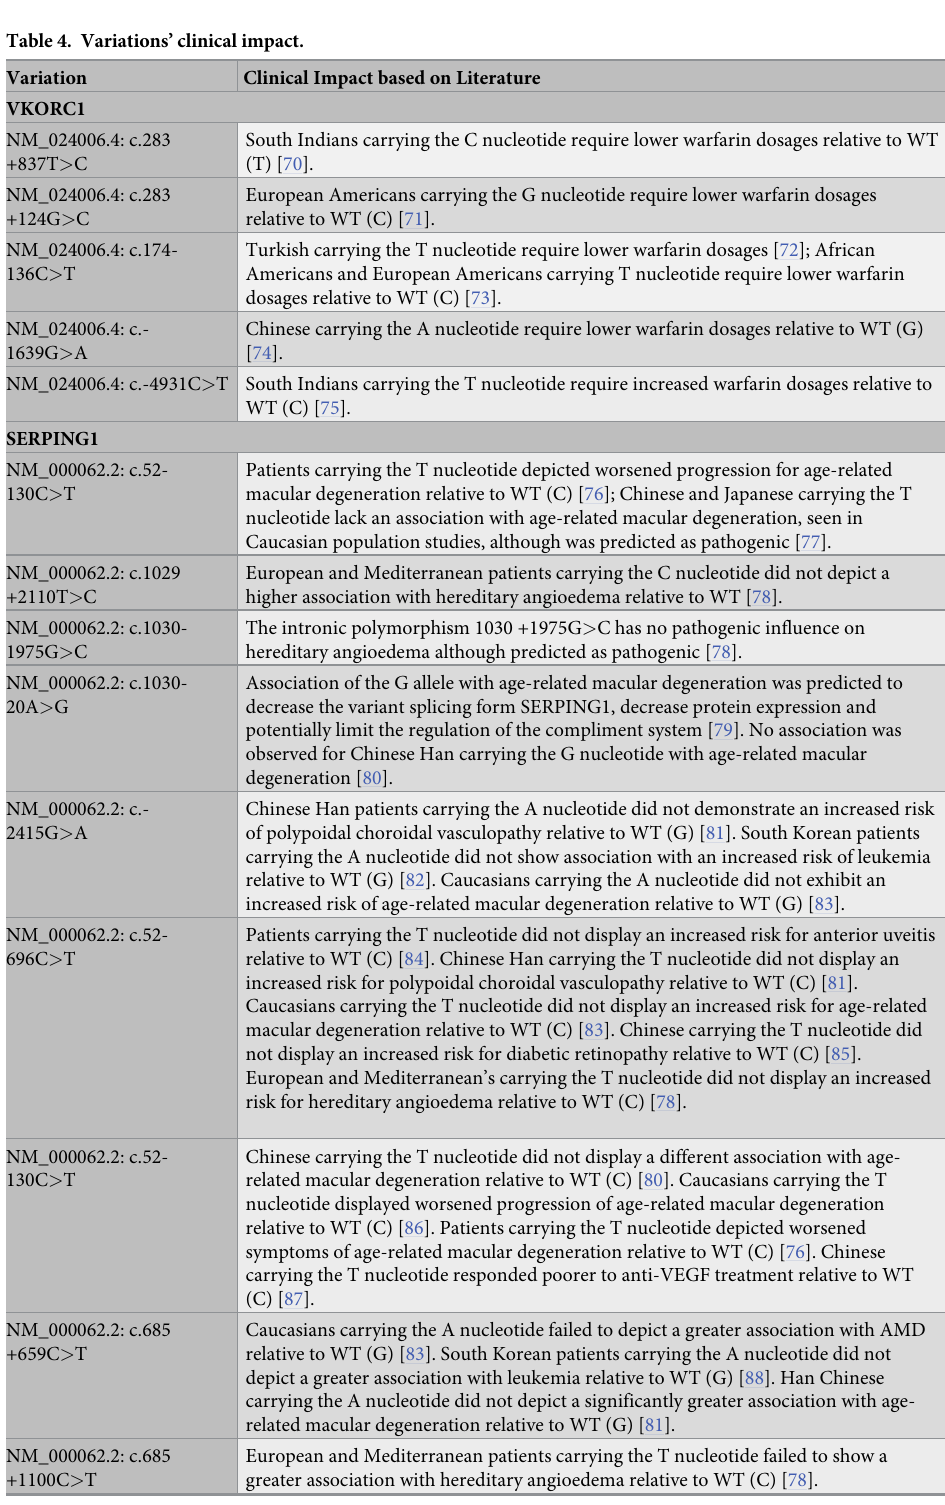
Table 4. Variations’ clinical